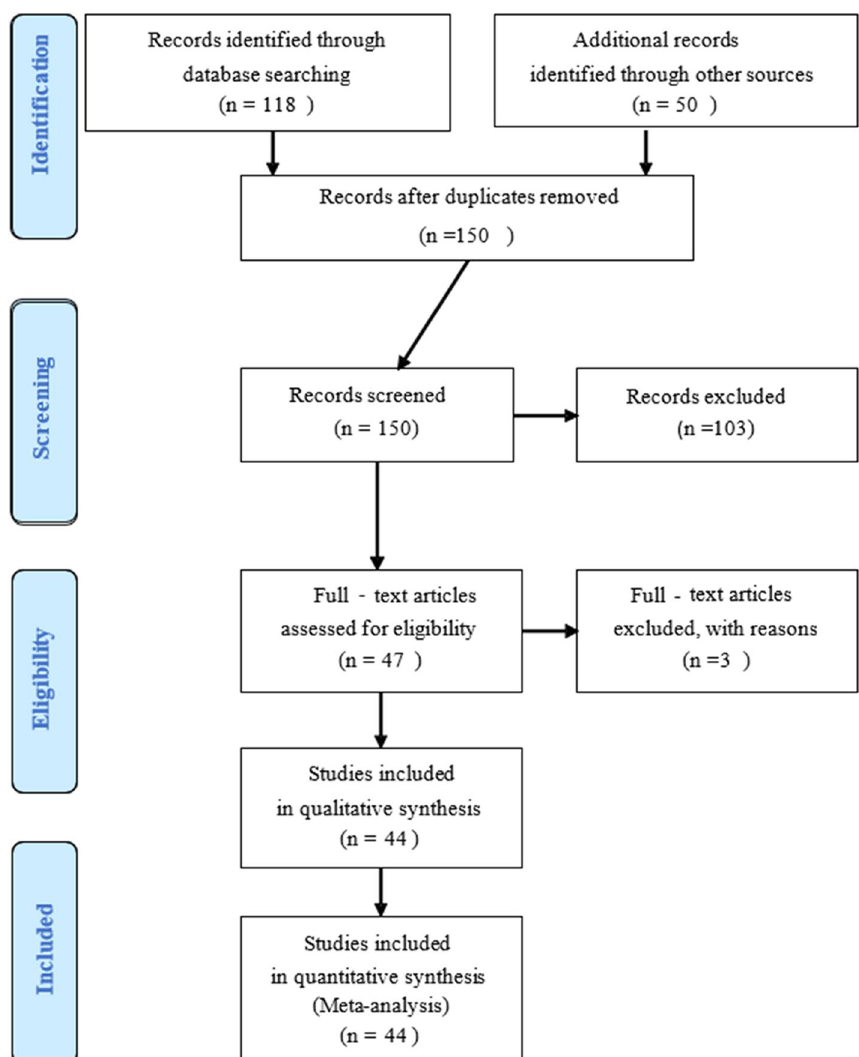
Fig. 1 PRISMA flow chart for the current